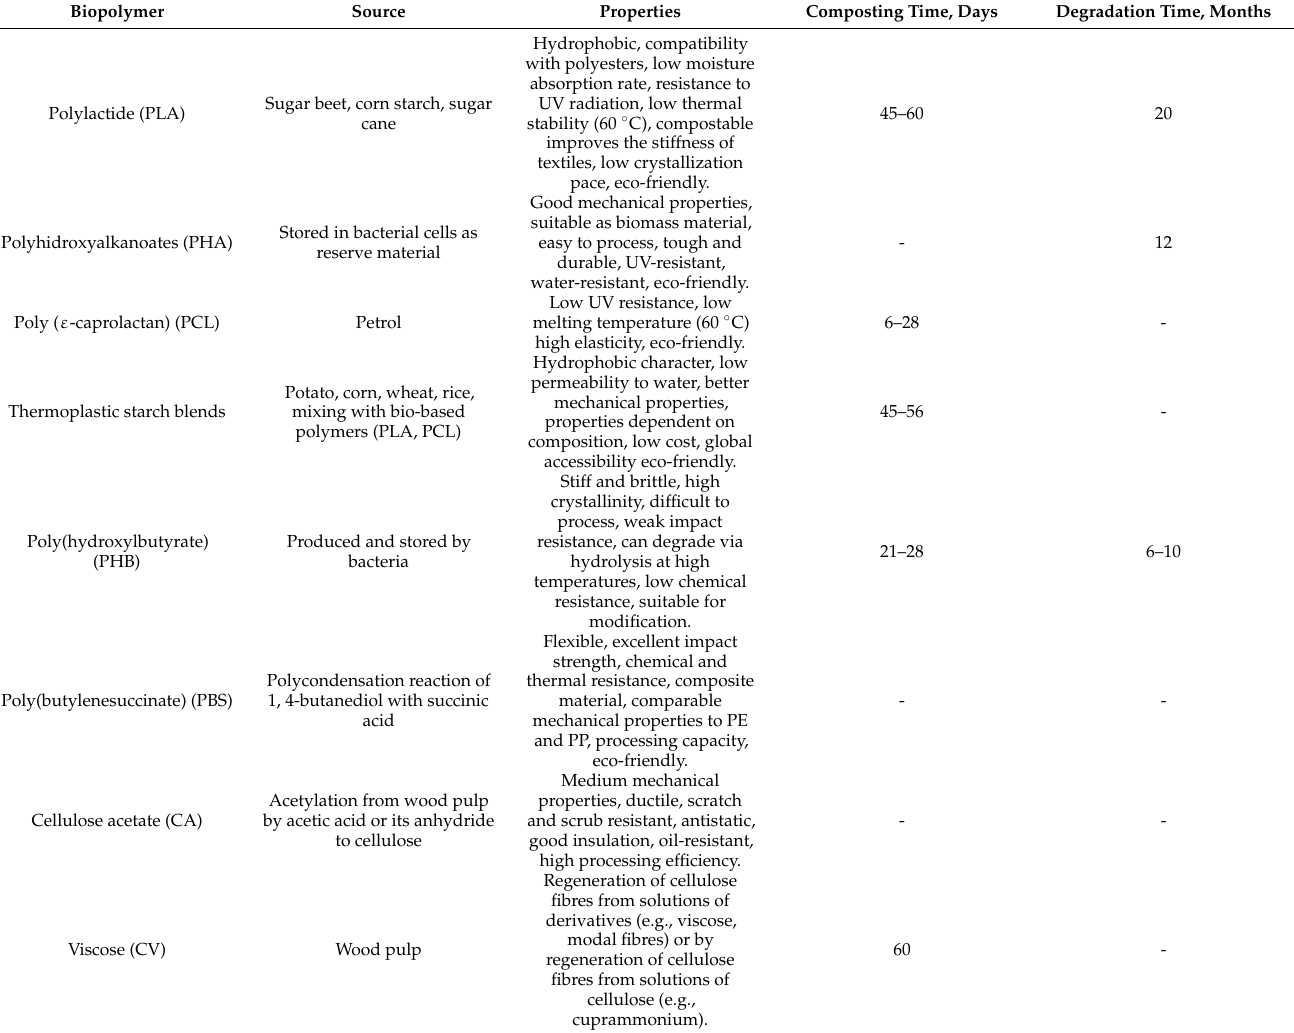
Table 3. Characterization and degradation rate of biopolymers